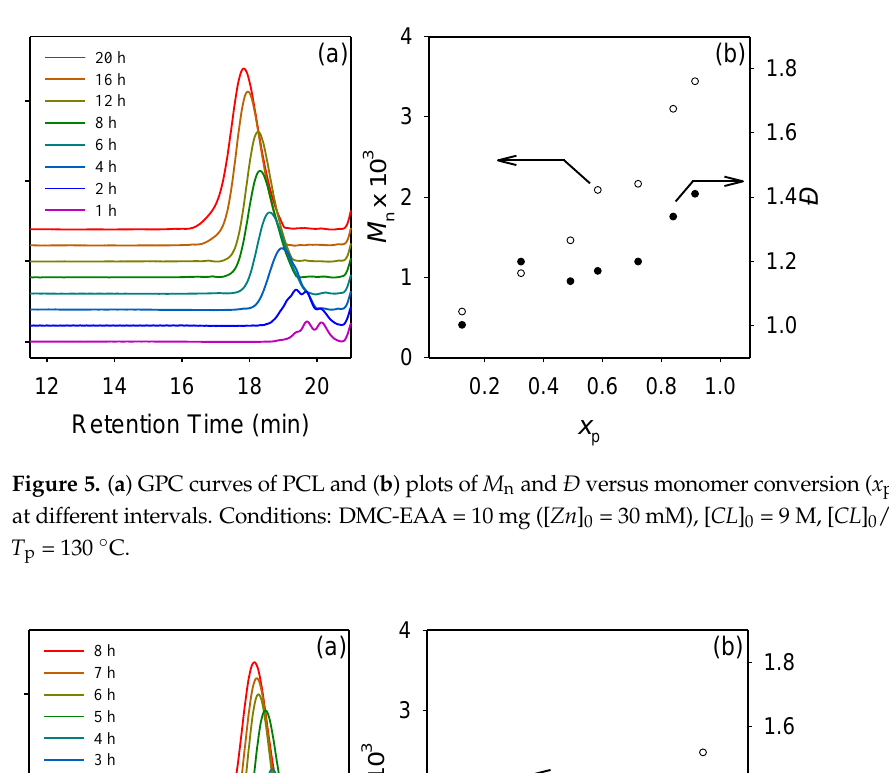
the time–conversion plots in Figure 4; 5 overall activation energy.